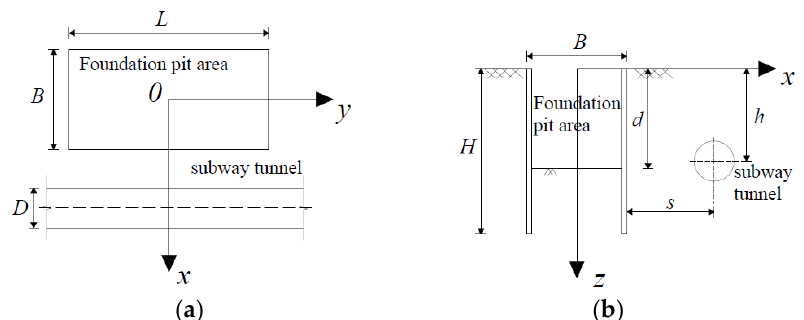
Figure 1. Calculation model of the influence of foundation pit excavation on the tunnel. ( a ) Vertical view. ( b ) Front view.